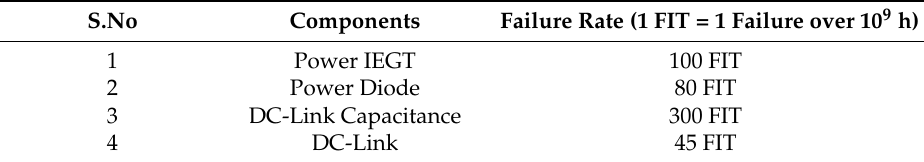
Table 4. Failure rate for power converter [31].